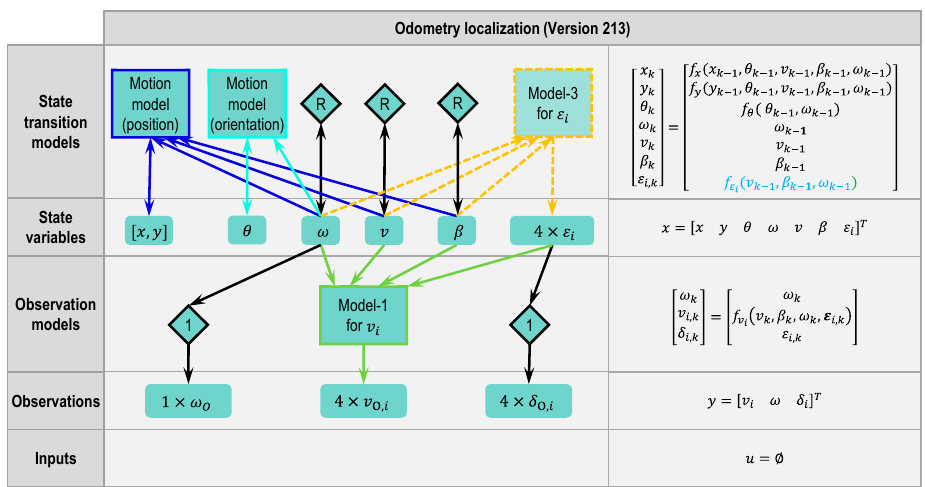
Figure 12. Modular approach to designing a state estimator for odometry localization (Version 213 based on Version 212, changes marked with dashed lines or dashed blocks and blue letters, respectively).